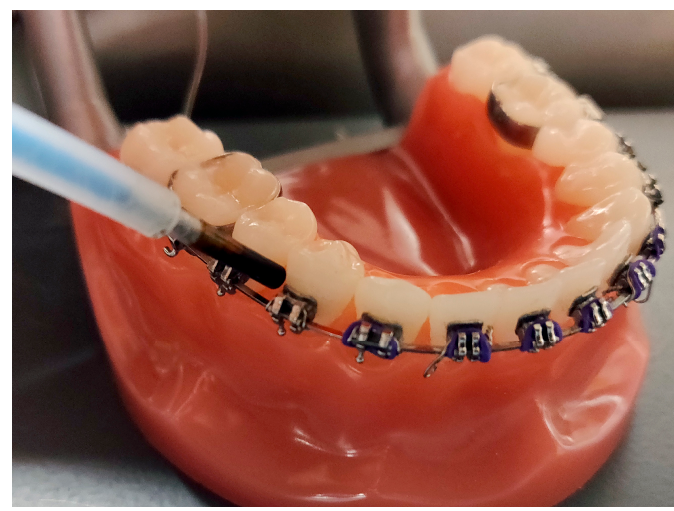
Figure 1. Near-infrared (NIR) scanning fiber endoscope (SFE) prototype on a typodont with orthodontic